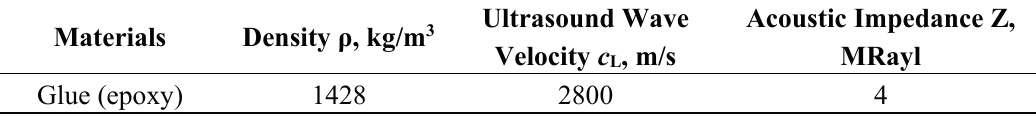
Table 2. Properties of the adhesive